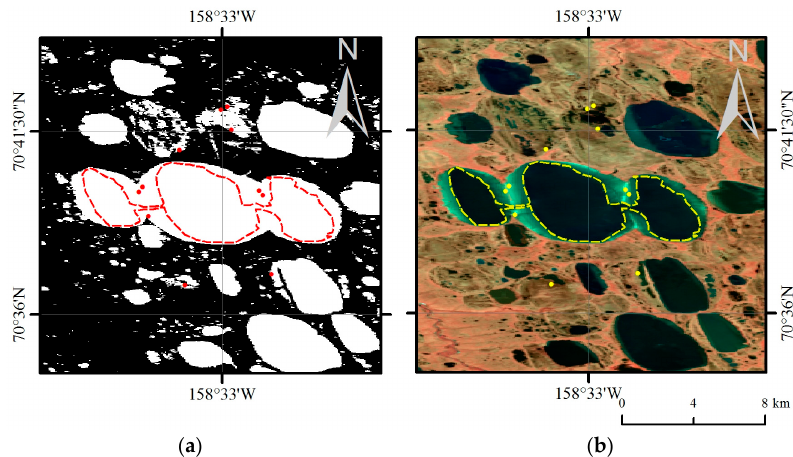
Figure 1. ( a ) The map of Global Surface Water v1.0 (GSW1_0) for 2015. ( b ) The combined Landsat 8 images from April to October in 2015. The red points in ( a ) and the yellow points in ( b ) denote mismatched regions (water in GSW1_0 and land in Landsat).